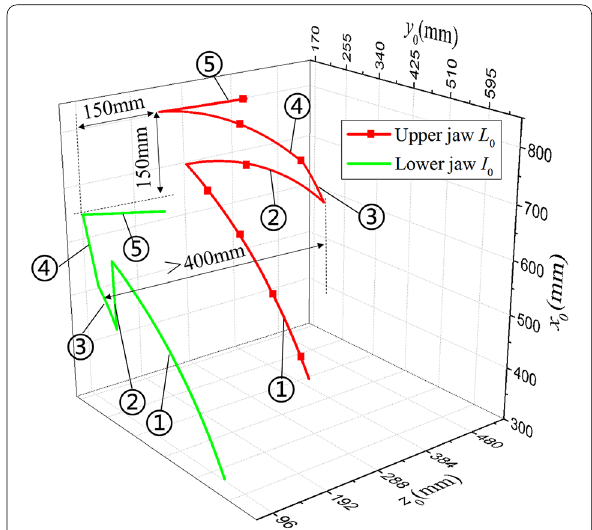
Figure 13 Motion trajectory of lower jaw I 0 and upper jaw L